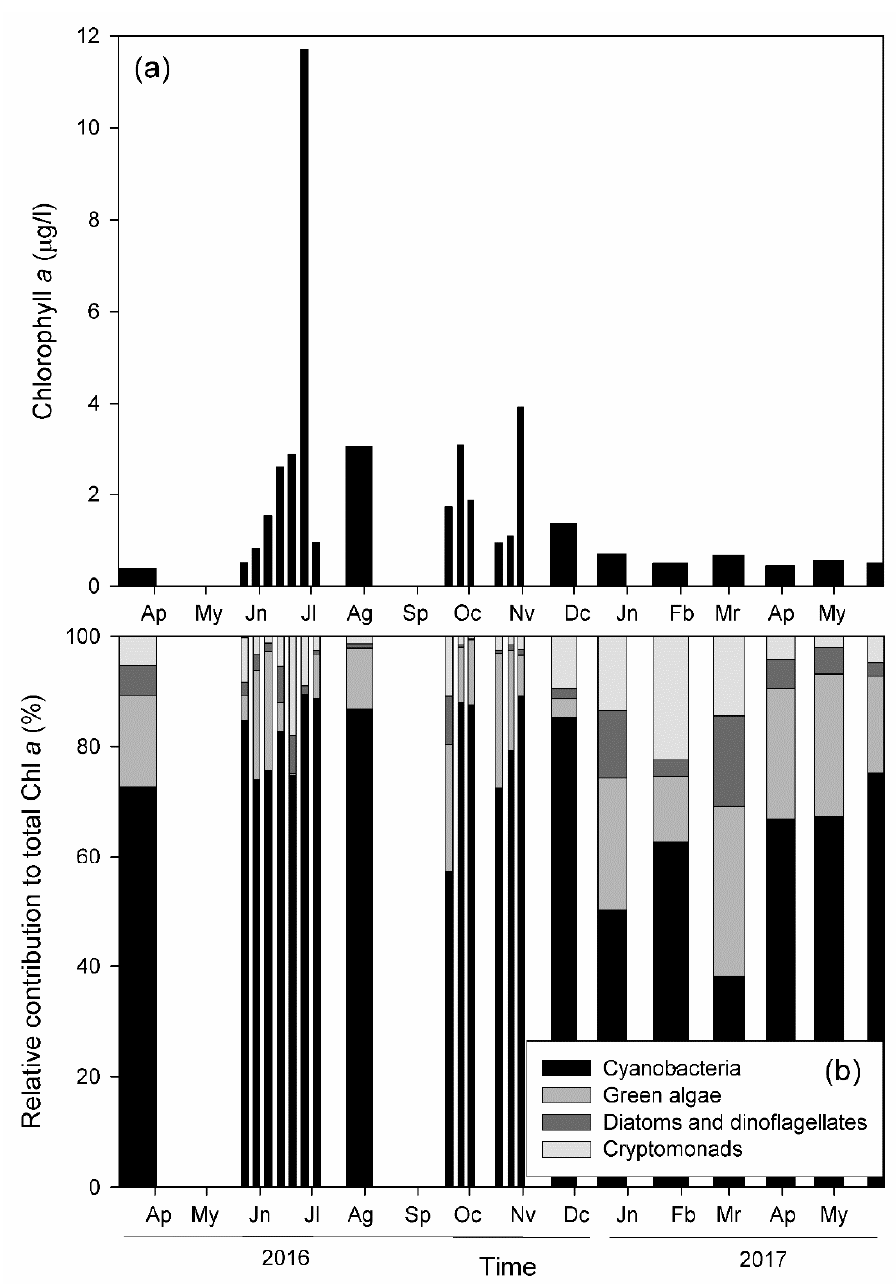
Figure 3. ( a ) Annual cycle of total chlorophyll a (Chl a ) concentration and ( b ) relative contribution of the main phytoplanktonic groups (cyanobacteria, green algae, diatoms and dinoflagellates, and cryptomonads), derived from fluoroprobe measurements (wide bars correspond to monthly sampling and narrow bars to weekly sampling).